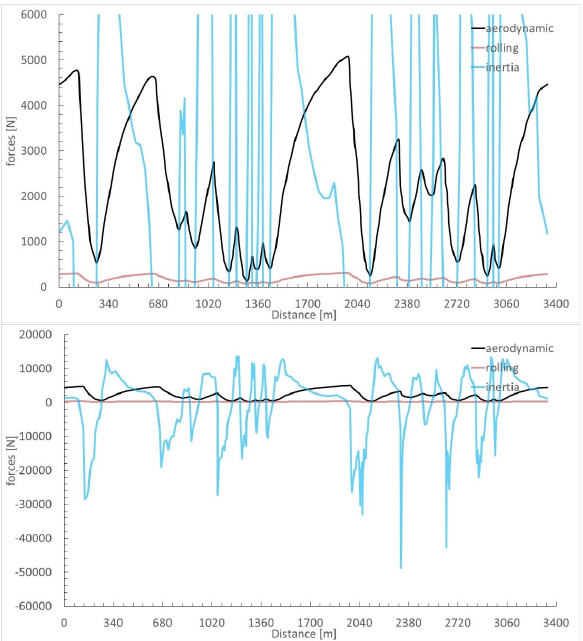
Fig. 4: longitudinal forces acting on the car, aerodynamic, rolling friction and inertia forces